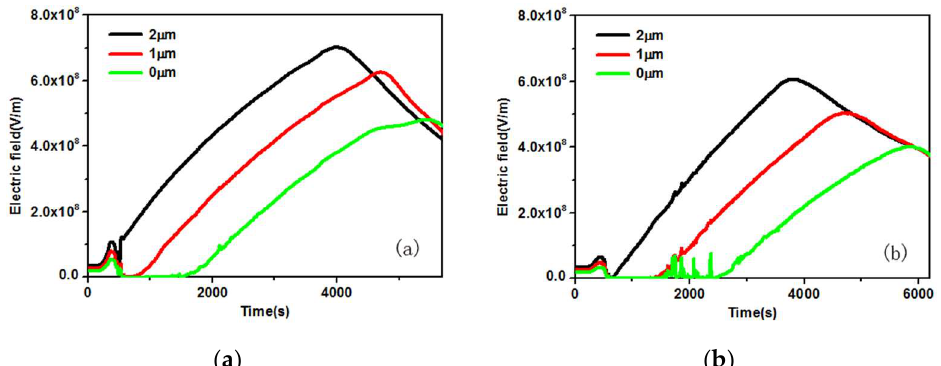
Figure 4. Time evolution of the internal electric field at the core for fibers F1 ( a ) and F2 ( b ); Different color data line comes from sampling points in different locations, 2 µm (black), 1 µm (red), and 0 µm (green) from the left side of the core center.